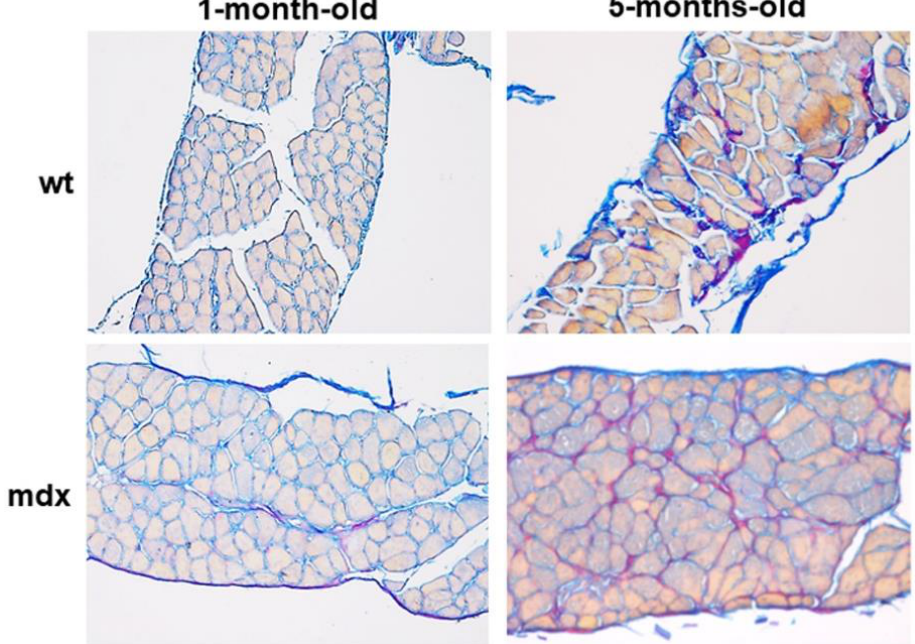
Figure 4. Representative sections of DF muscles stained with Herovici’s staining. The more mature and cross-linked collagen stains purple, whilst the less mature and young collagen (including reticular collagen fibres) stains blue. Original magnification: 20×.